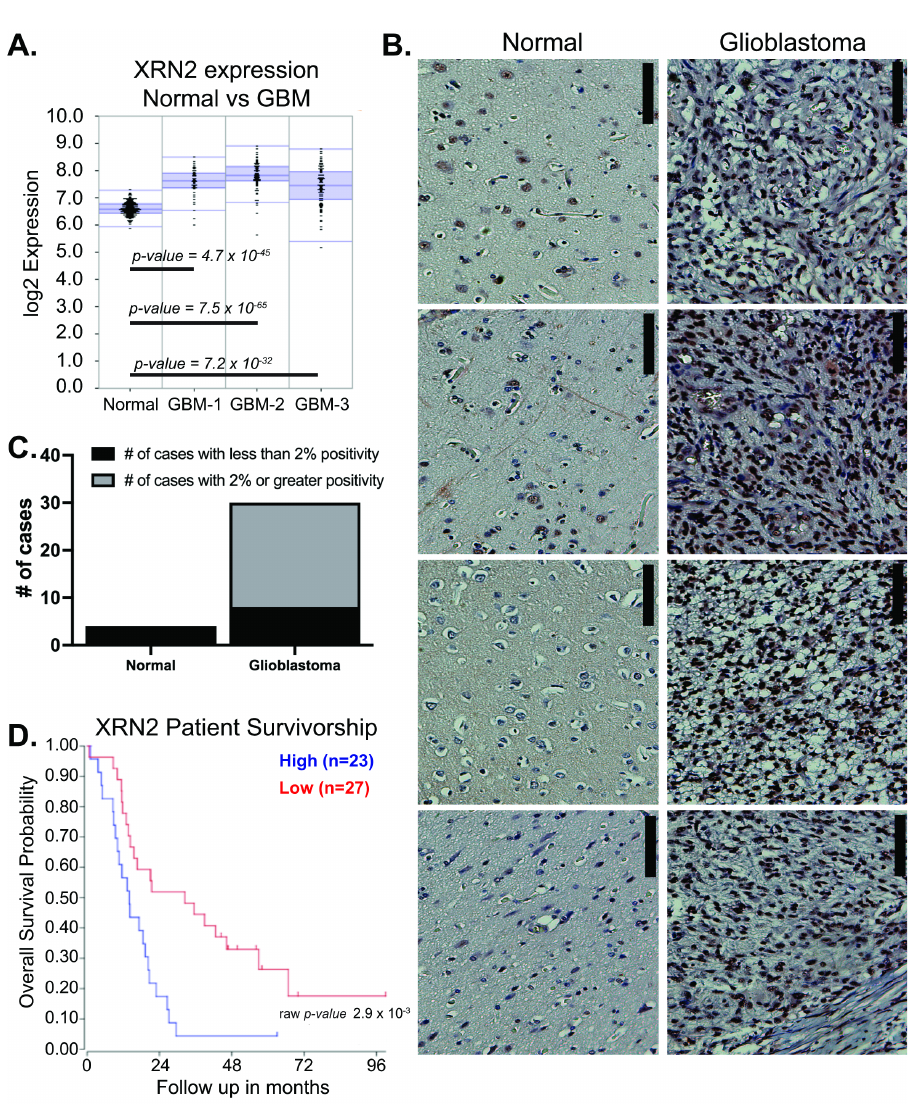
Figure 1. XRN2 expression confers with glioblastoma disease and poor patient survival. ( A ) Log2 XRN2 mRNA expression levels in normal (Berchtold, 172 samples), GBM-1 (Pfister, 46 samples), GBM-2 (Loeffler, 70 samples), and GBM-3 (Hegi, 84 samples) databases. Graph generated from R2: Genomics Analysis and Visualization Platform. ( B ) Representative XRN2 immunohistochem- istry staining of normal and glioblastoma patient samples. Brown signal is XRN2. Blue signal is hematoxylin (nuclei). Scale bar is 100 micron. ( C ) Quantification of XRN2 signal from immunohis- tochemistry staining of normal and GBM patient samples. A signal of less than 2% is considered negative, while a signal of 2% or greater is considered positive. ( D ) Glioma patient survival outlook based on XRN2 mRNA levels (Kawaguchi, 50 patients). Blue line denotes patients with high expres- sion of XRN2. Red line denotes patients with low expression of XRN2. Graph generated from R2: Genomics Analysis and Visualization Platform. Statistical analysis was performed using the default setting provided by